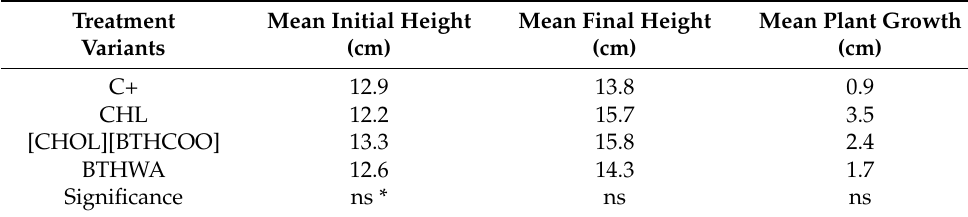
Table 3. Plants’ height at the beginning and end of the experiment. Treatment